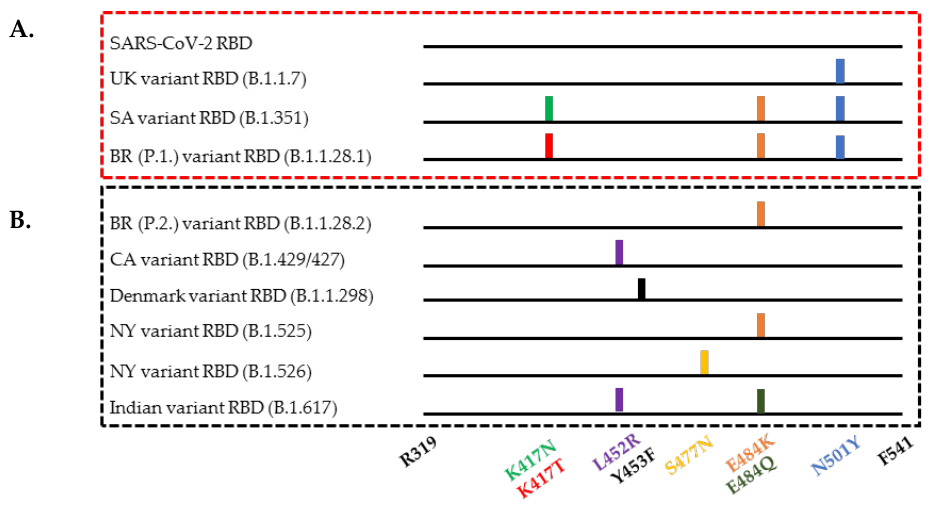
Figure 1. Mutations in the spike RBD protein of the currently circulating SARS-CoV-2 variants, compiled from these referenced articles [2–10,22]. ( A ) SARS-CoV-2 and three variant RBDs included in this study. ( B ) Variant RBDs not addressed in this